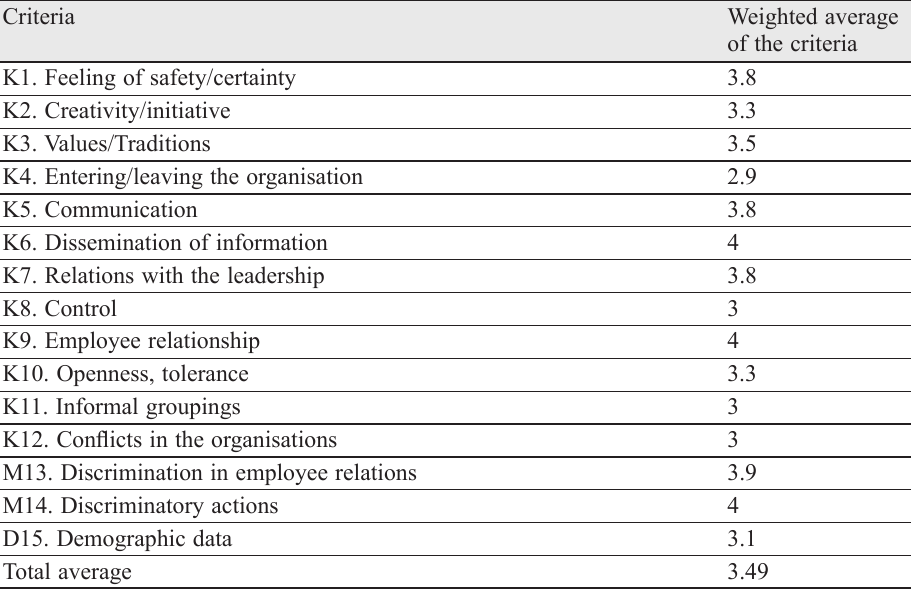
Table 1 . Weighted average of the criteria presented for assessment Criteria Weighted average